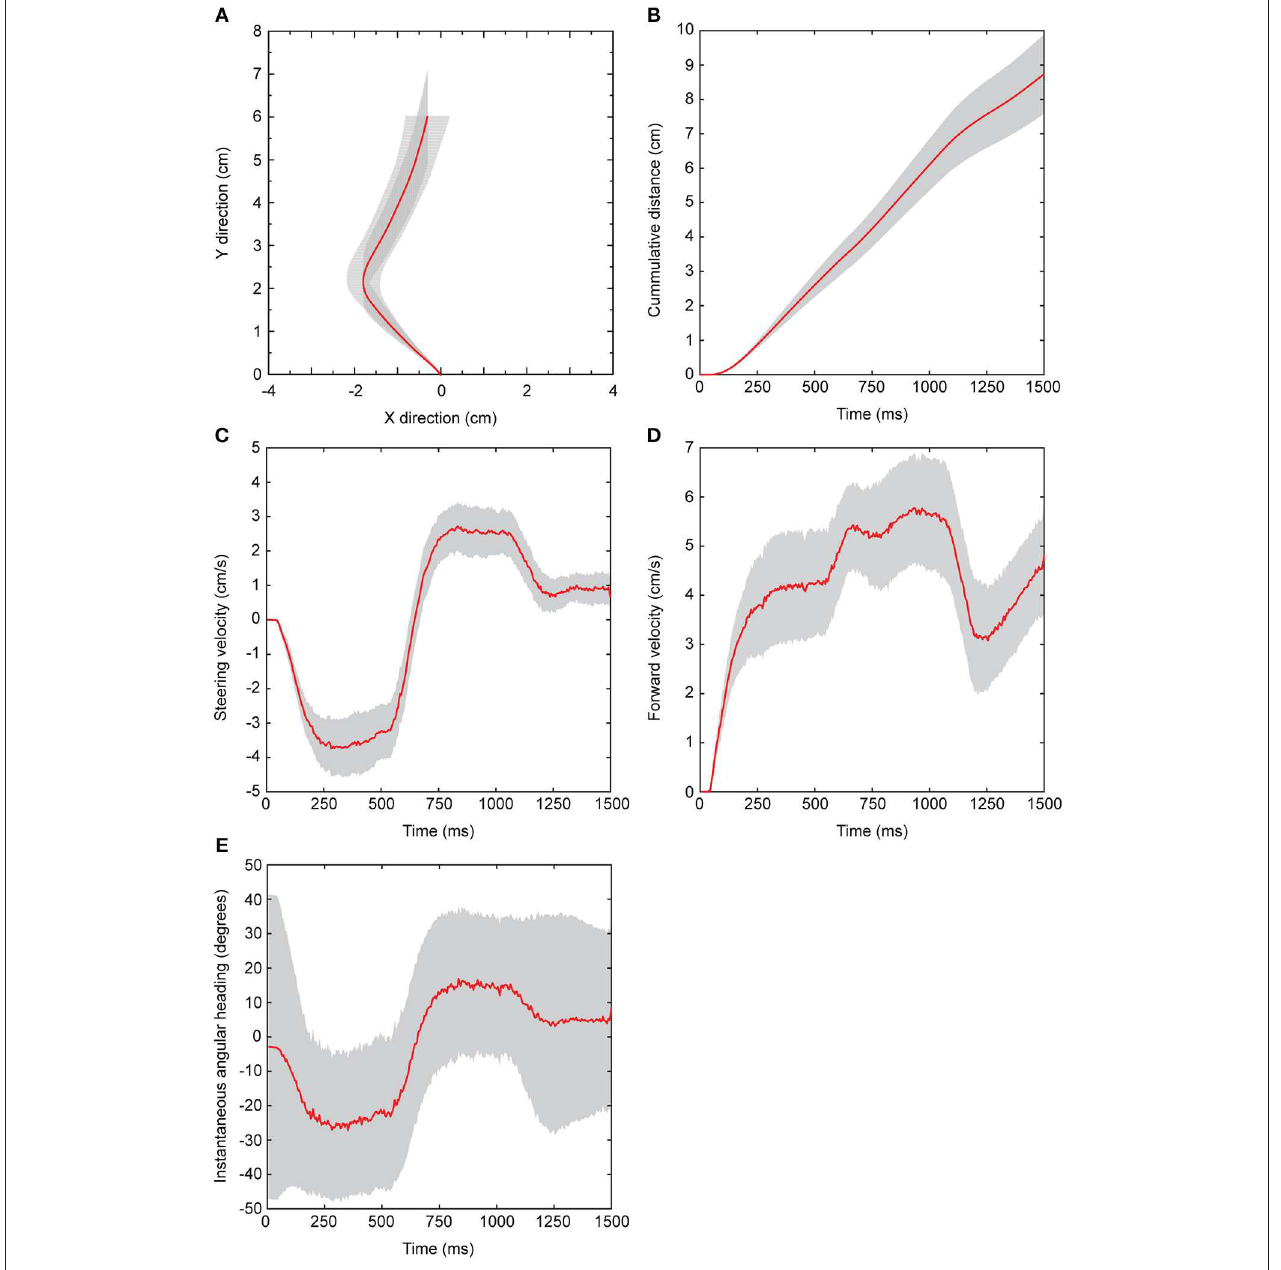
FIGURE 2 | Response features measured from the spherical treadmill system. All data shown are derived from Floridian Ormia ochracea in response to a standard attractive cricket song (50 pulses/s) that was broadcast from the left speaker for 500ms, and then switched to the right speaker for the remaining 500ms of stimulus presentation. (A) Plots of x and y values show a reconstructed virtual walking path. (B) Depicts total distance traveled as a function of time. Changes in x and y as a function of time represent steering (C) and forward (D) velocities, respectively. Instantaneous angular headings (E) are derived from converting x and y values from the cartesian plane to polar coordinates. Negative angular headings indicate turning to the left while positive angular headings indicate turning to the right. Red lines represent the grand mean across 16 flies and shaded gray areas represent 95% confidence interval around the mean.